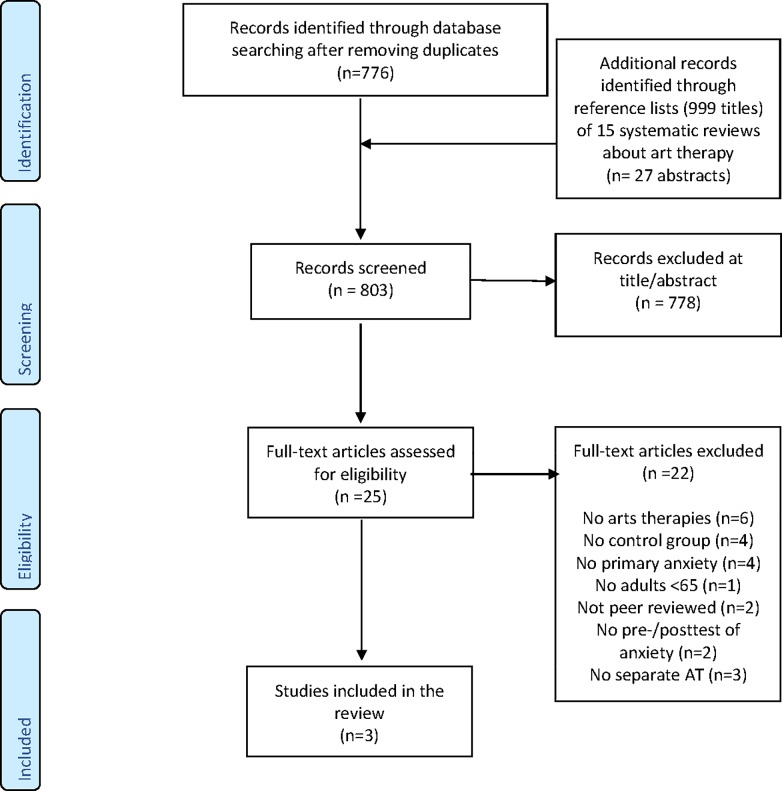
PRISMA flow diagram.